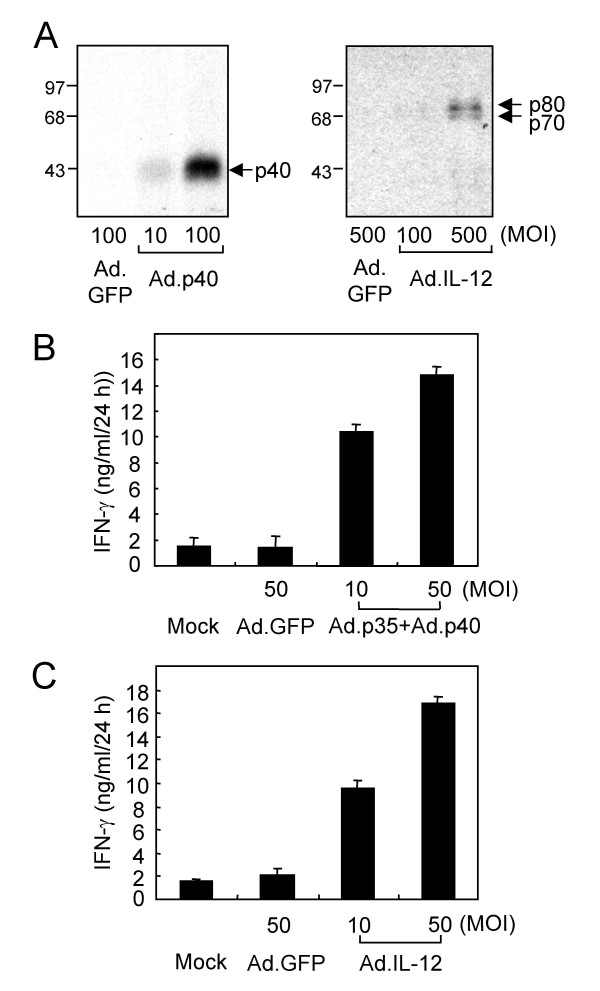
The recombinant adenoviruses encoding murine p35 and/or p40 subunits express biologically active IL-12. (A) HeLa cells were transduced with Ad.GFP, Ad.p40, or Ad.IL-12 at the indicated MOIs. Cells or culture media were harvested 48 h after transduction. Cleared lysates of cells transduced with Ad.GFP or Ad.p40 were immunoblotted with anti-IL-12 antibody (left panel). The culture media from HeLa cells transduced with Ad.IL-12 or Ad.GFP were immunoprecipitated with anti-IL-12 antibody. The immunoprecipitates were dissolved in SDS sample buffer without reducing agent and subjected to SDS-PAGE, followed by immunoblotting with anti-IL-12 antibody (right panel). Molecular size markers in kilodaltons are shown at the left. The positions of p40, p35–p40 heterodimer (p70) and p40 homodimer (p80) are indicated by arrows. (B and C) HeLa cells were mock-transduced or transduced with either a 1:1 (pfu ratio) mixture of Ad.p35 and Ad.p40, or Ad.IL-12, or Ad.GFP, at the indicated MOI. Splenocytes from naïve mice were incubated with the culture supernatants for 24 h. ELISA was performed to determine the IFN-γ levels after incubation. Data are means ± SD of two independent experiments, each performed in duplicate.